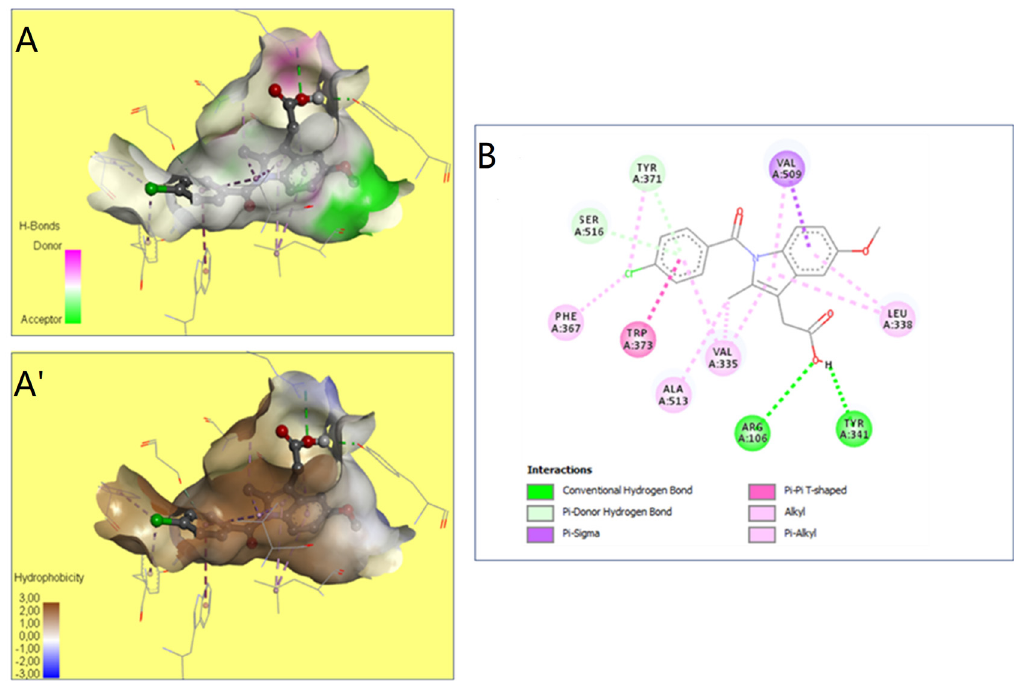
Figure 6. The representation of the 3D structure of «Indomethacin» bounded to the pocket region of COX-2. Micrographs of the pocket region with hydrogen bond ( A ) and hydrophobicity illustrations ( A′ ) and the corresponding 2D diagram of interactions ( B ).